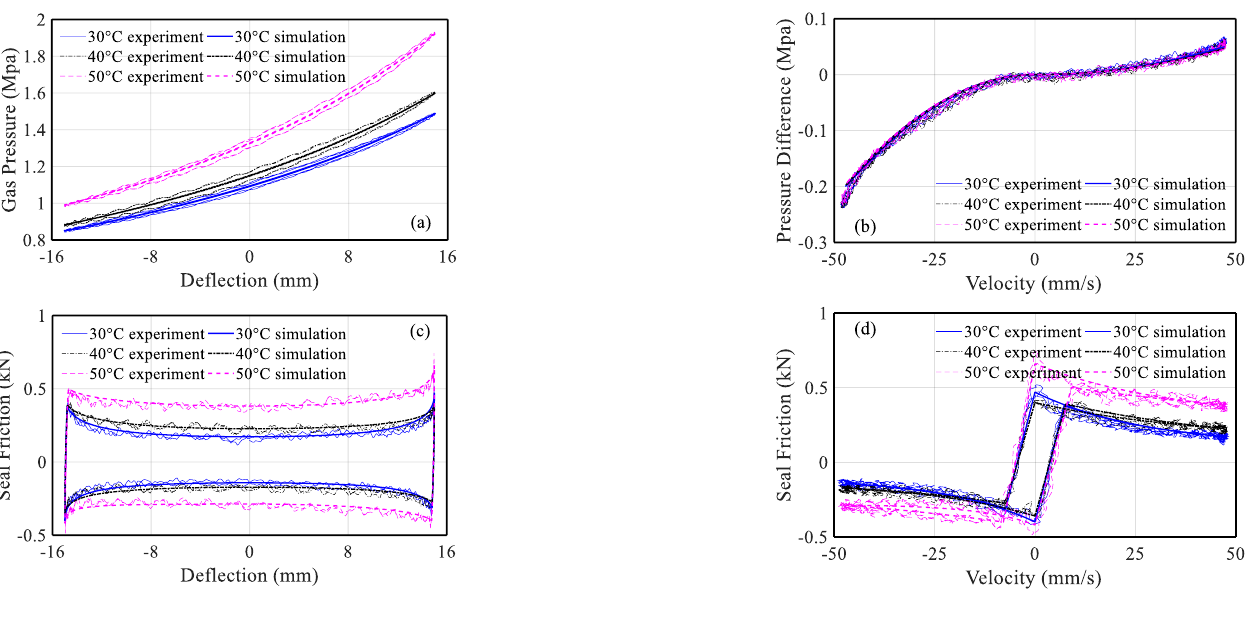
Figure 7. Comparisons of experimental and simulated gas pressure-deflection ( a ), pressure difference-velocity ( b ), seal friction-deflection ( c ), and seal friction-velocity ( d ) relationships at different temperatures (0.5 Hz).